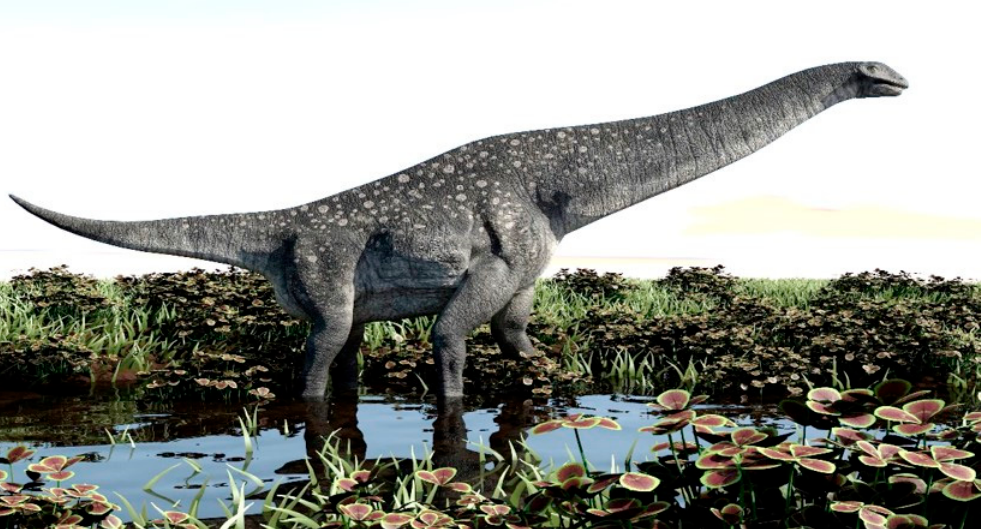
Figure 1. Depiction of a titanosaur sauropsid dinosaur that roamed the earth during the Jurassic and Cretaceous Periods. This grass-eater probably played an important role in the evolution of grasslands and setting the scene for subsequent large herbivores.